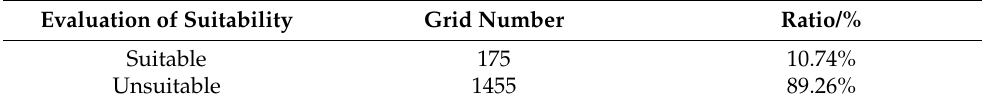
Table 5. Number and proportion of suitable grids.